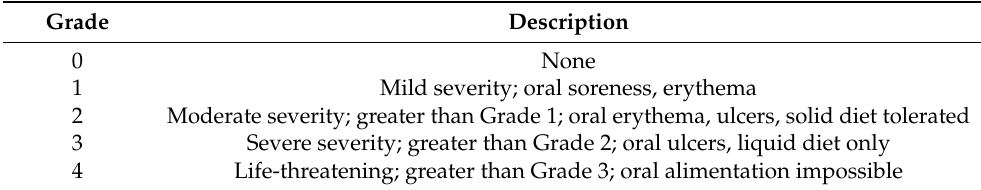
Table 1. World Health Organization Oral Mucositis Grading Scale. Grade